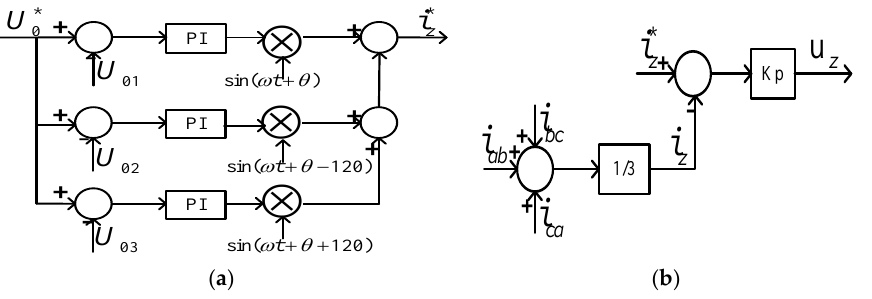
Figure 7. The dc link voltage control. ( a ) zero sequence current generation. ( b ) the zero sequence current following.